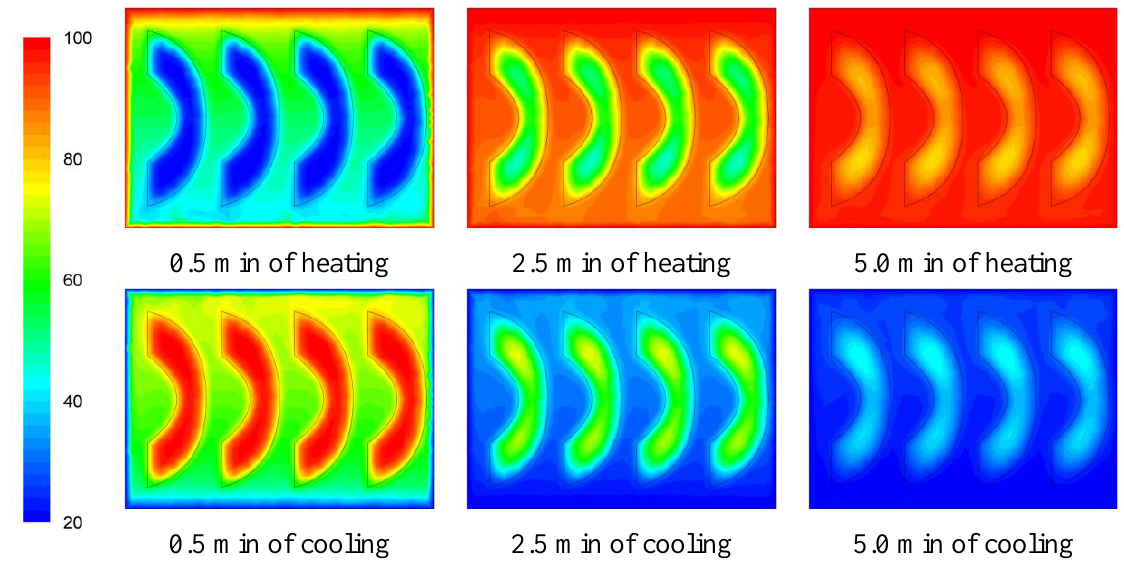
Figure 8. Temperature (°C) contours for peach halves in syrup at different heating and cooling times during heating (at 100 °C) and cooling (at 20 °C) for the “sideward”